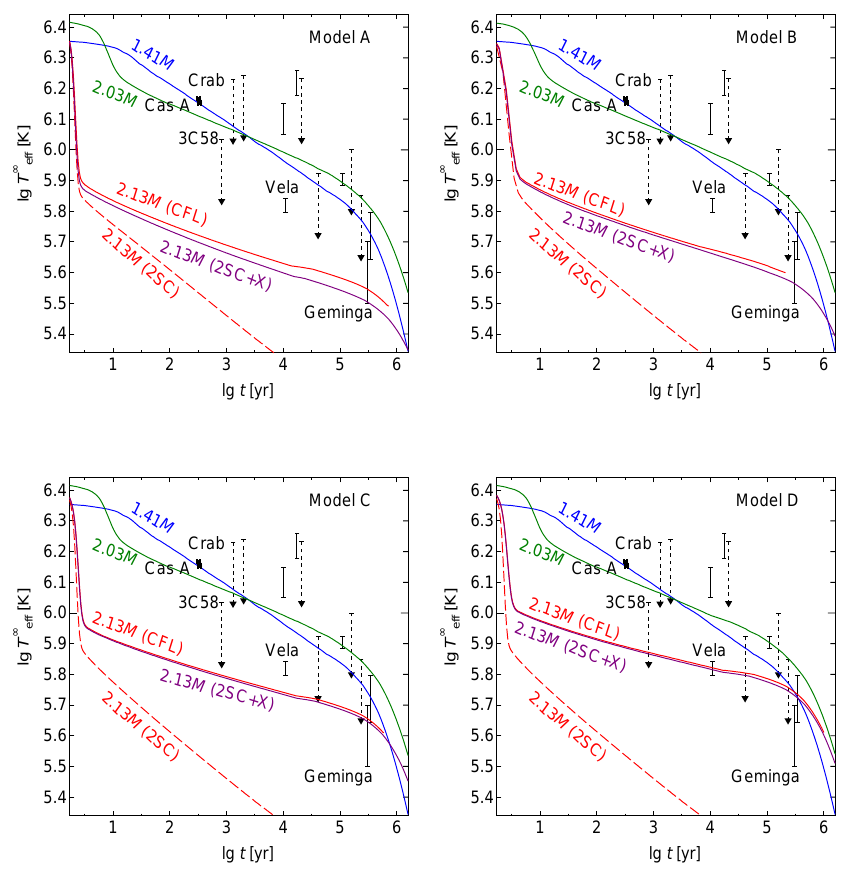
Figure 3. Cooling curves with various superfluid models. Blue (green) line denotes 1.41 M ⊙ (2.03 M ⊙ ), respectively. Red solid (dashed) line denotes 2.13 M ⊙ with CSC paring of CFL (2SC), respectively. Purple line denotes 2.13 M ⊙ with 2SC + X model. Each superfluid models are shown on the right-top corners of each